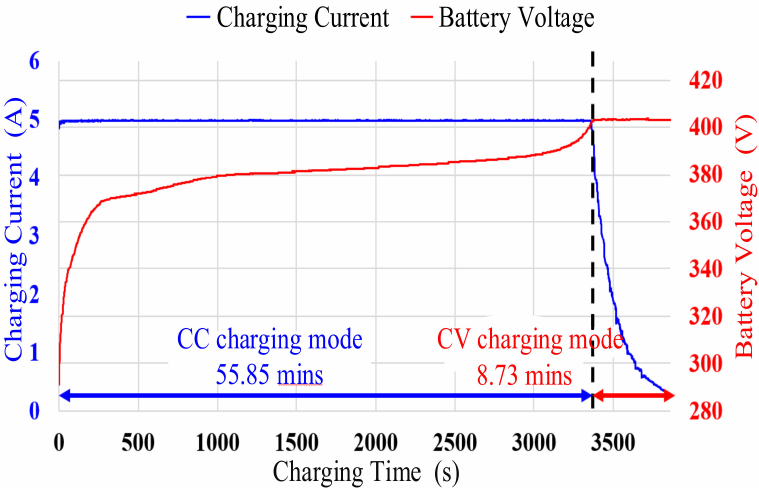
Figure 18. CC–CV charging curve of the fabricated